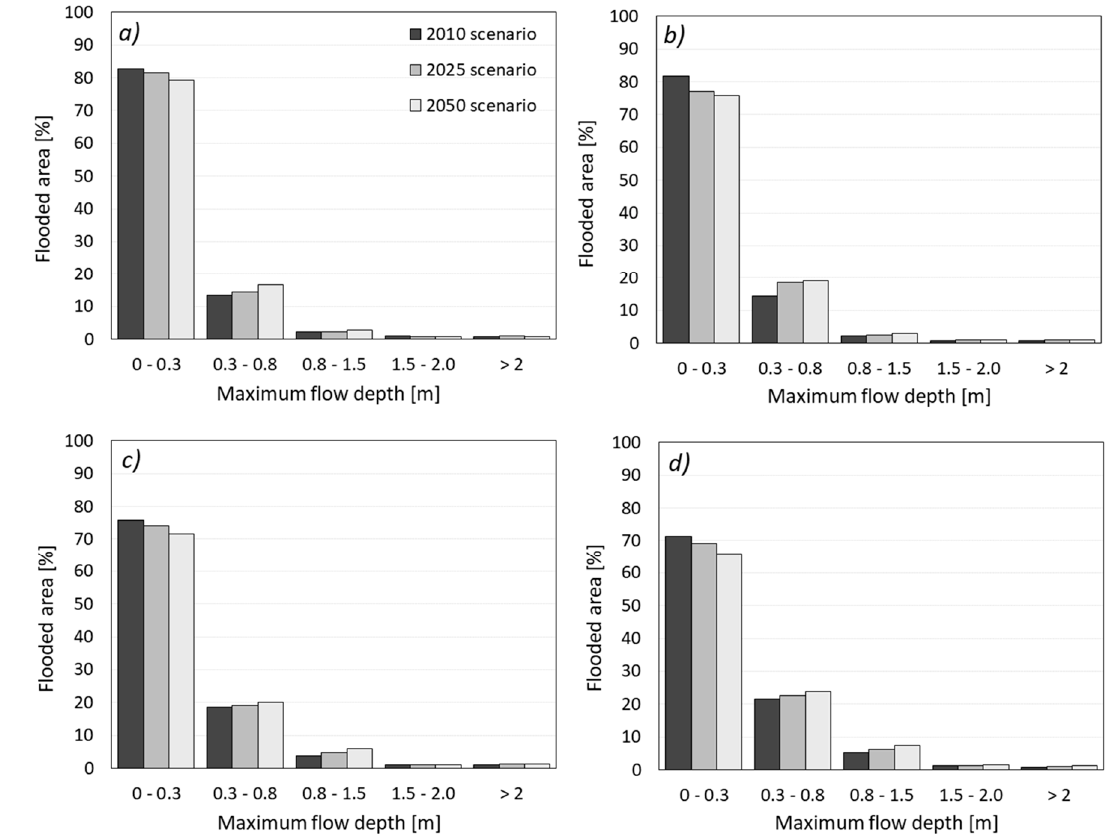
Figure 8. Percentage of flooded areas for each range of maximum flow depths (m): ( a ) T = 2 years; ( b ) T = 5 years; ( c ) T = 10 years; and ( d ) T = 20 years.